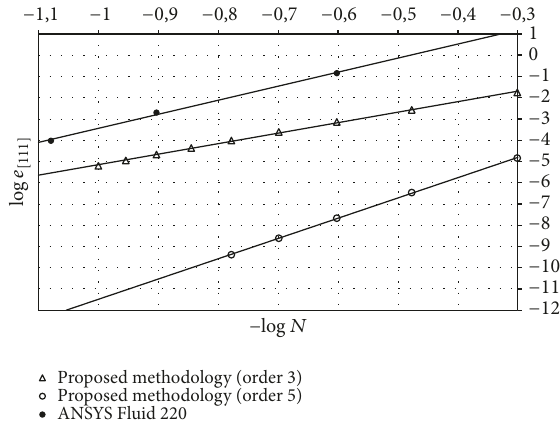
̂𝜆 1/𝑁 ( ℎ -convergence). Figure 3: Cube: ̂𝜆 Figure 2: Cube: 111 versus